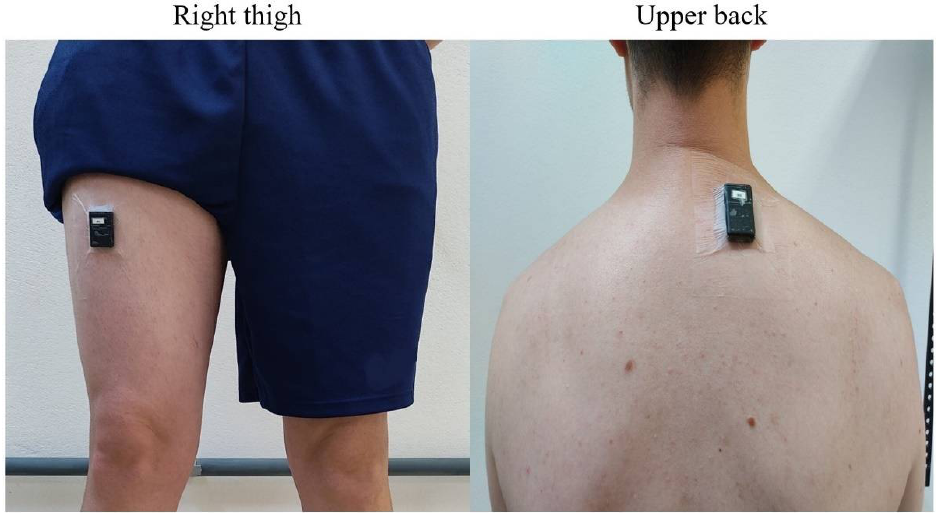
Figure 1. Illustration of accelerometer placement. Left: right thigh (midway between the iliac crest and the upper line of patella); right: upper back (level of T1/T2).